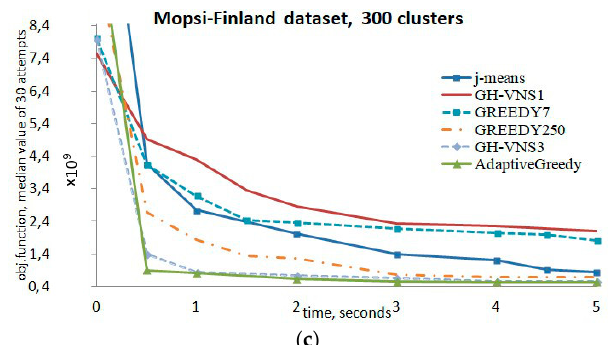
Figure 6. Comparative analysis of the convergence speed. Dependence of the median result on computation time for: ( a ) Individual Household Electric Power Consumption (IHEPC) data set, 50 clusters,